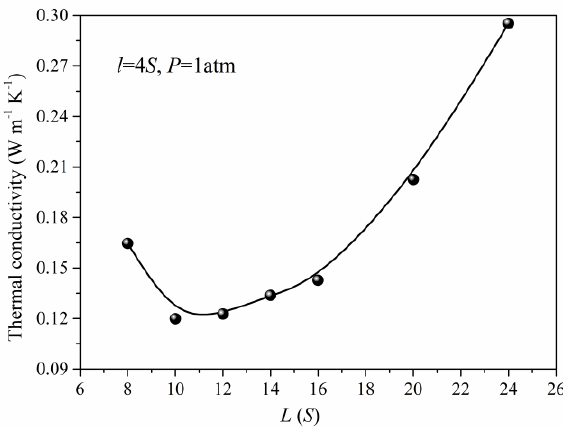
Figure 6. The thermal conductivity for different unit length ( L ).